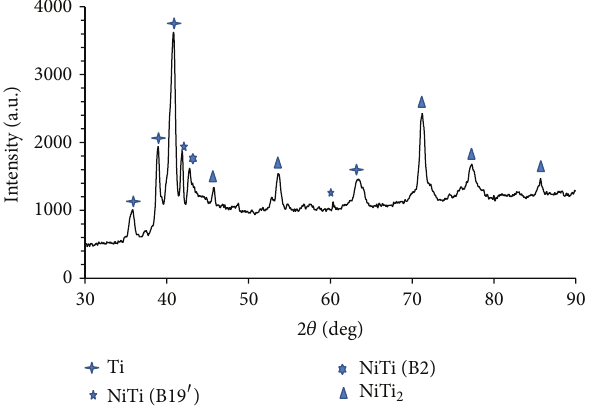
Figure 7: XRD patterns of Ti45Ni55 coating.